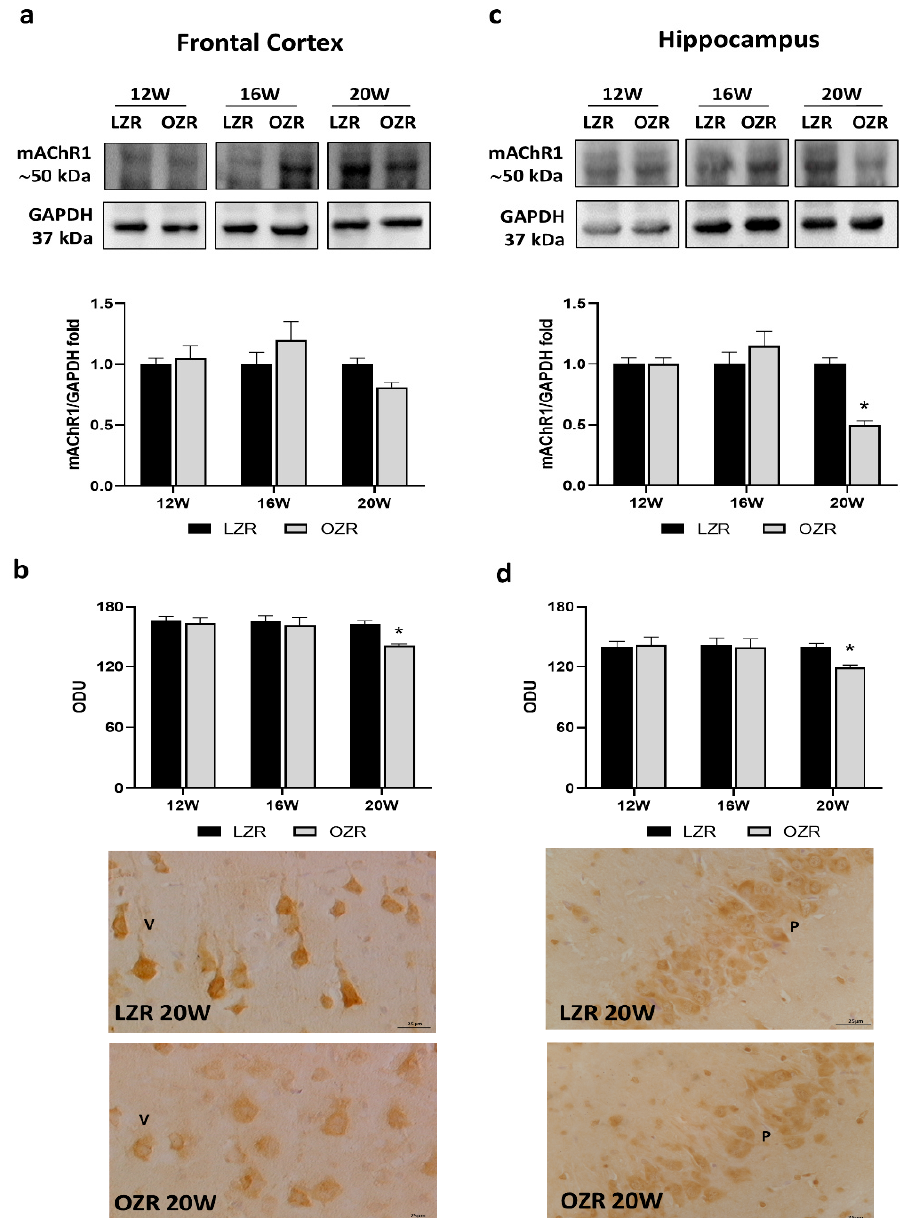
Figure 3. Immunoblotting and immunoreaction of muscarinic acetylcholine receptor subtype 1 (mAChR1). Lysates of the frontal cortex ( a ) and hippocampus ( c ) from lean Zucker rats (LZRs) and obese Zucker rats (OZRs) at the age of 12, 16, and 20 weeks were immunoblotted using specific anti-mAChR1. Bar graphs indicate the densitometric analysis using LZRs as control, and GAPDH levels were used as a loading control. Blots are representative of one of three separate experiments; intensity values of mAChR1 immunostaining in the frontal cortex ( b ) and hippocampus ( d ) from LZRs and OZRs at the age of 12, 16, and 20 weeks measured in optical density units (ODUs). Data are mean ± S.E.M. * p < 0.05 vs. age-matched LZR. Representative pictures of 20-week-old LZRs and OZRs in the frontal cortex ( b ) and hippocampus ( d ). V: the fifth layer of the frontal cortex. P: pyramidal neurons of the hippocampus. 40× magnification. Calibration bar: 25 µm.